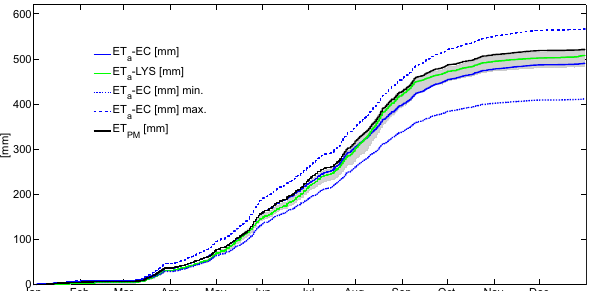
Figure 8. Cumulative ET a -LYS, ET a -EC (corrected according to Bowen ratio), ET PM on hourly basis for 2012. Displayed are also ET a -EC max and ET a -EC min. The area in grey shows the range of minimum and maximum cumulated ET a for the individual lysime-